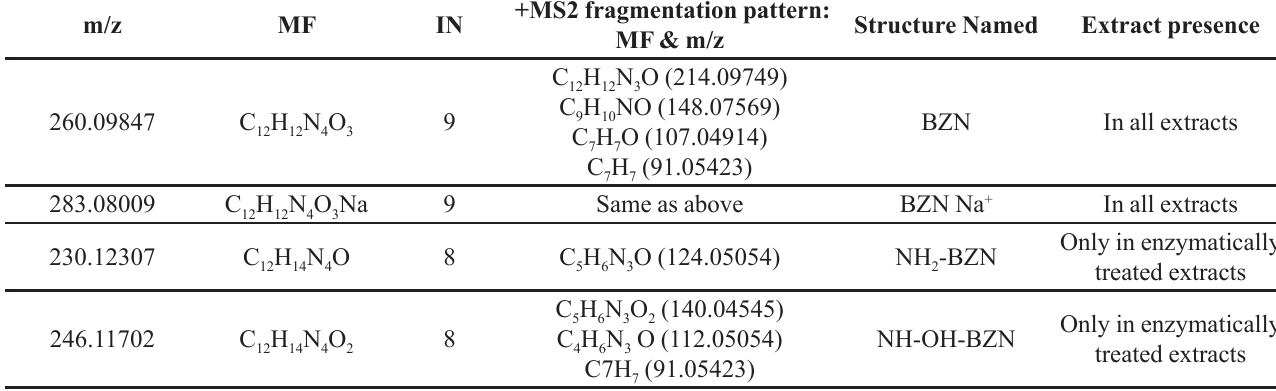
TABLE III - HPLC/MS/MS identified compounds related to BZN, their m/z and molecular formula (MF), instauration number (IN), and the extract in which they were